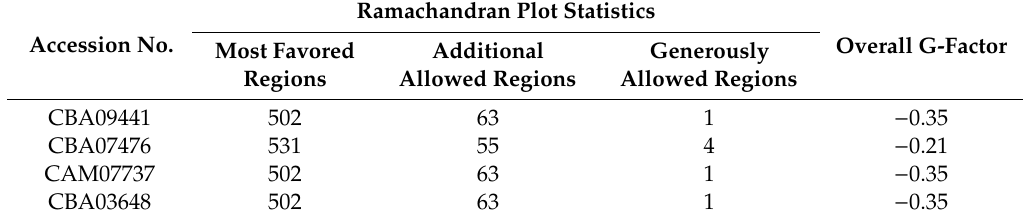
Table 6. Ramachandran plot statistics and overall G ‐ factors of N. meningitidis proteins .